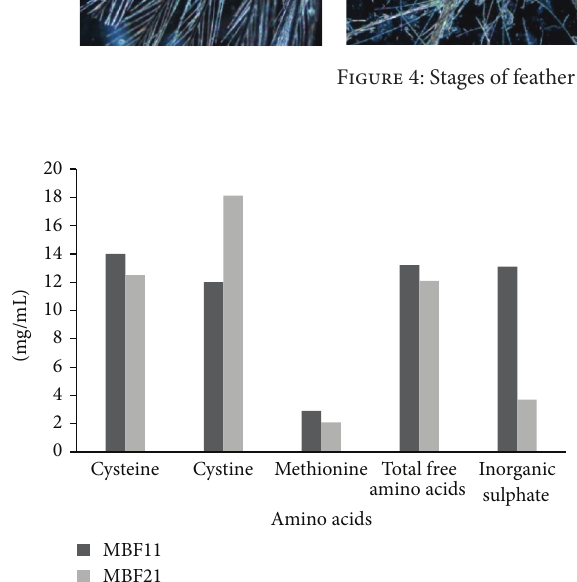
Figure 5: Comparison of analysis of culture filtrate of MBF11 and